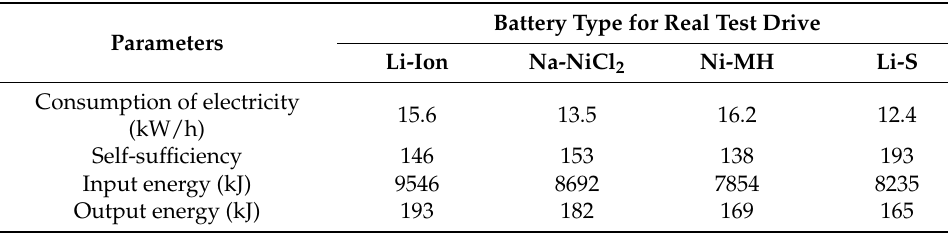
Table 1. Average real time battery test for different